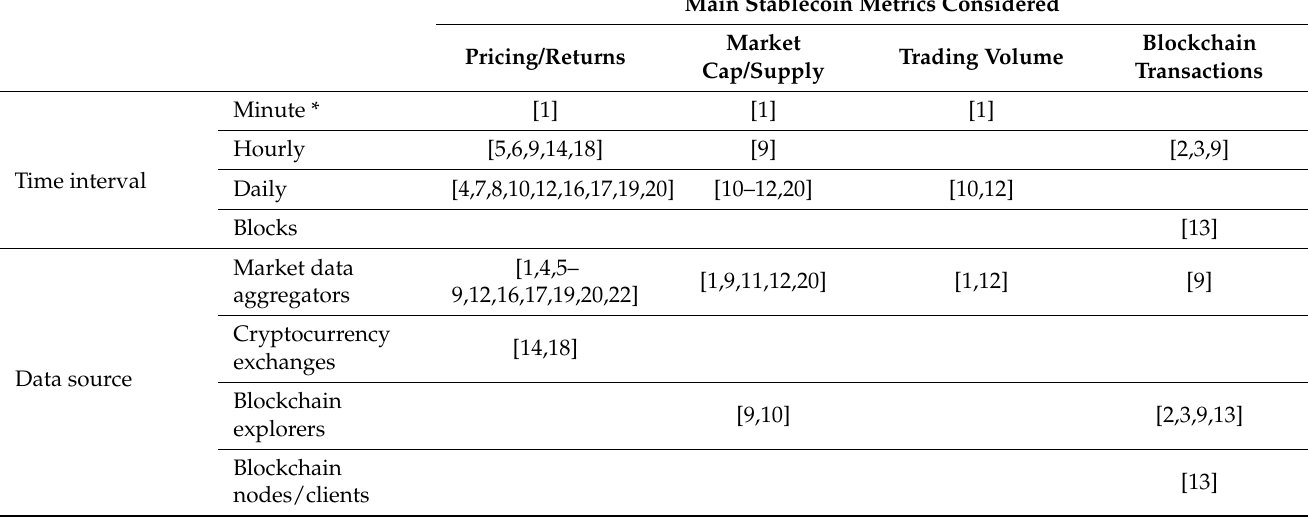
Table 3. Concept matrix merging stablecoin metrics considered with data time intervals and sources. The cells of the matrix show the IDs of the academic publications fitting the specific combinations. For an overview of the articles and their IDs, see Table